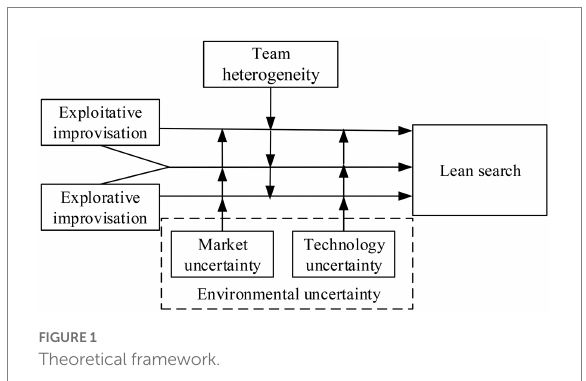
FIGURE 1 Theoretical